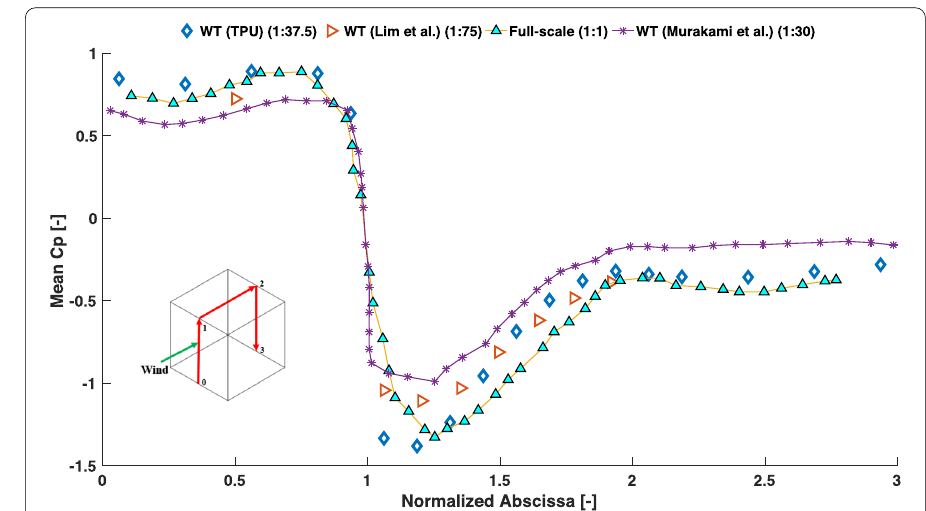
Fig. 3 Comparison of mean surface pressure coefficients from different wind tunnels